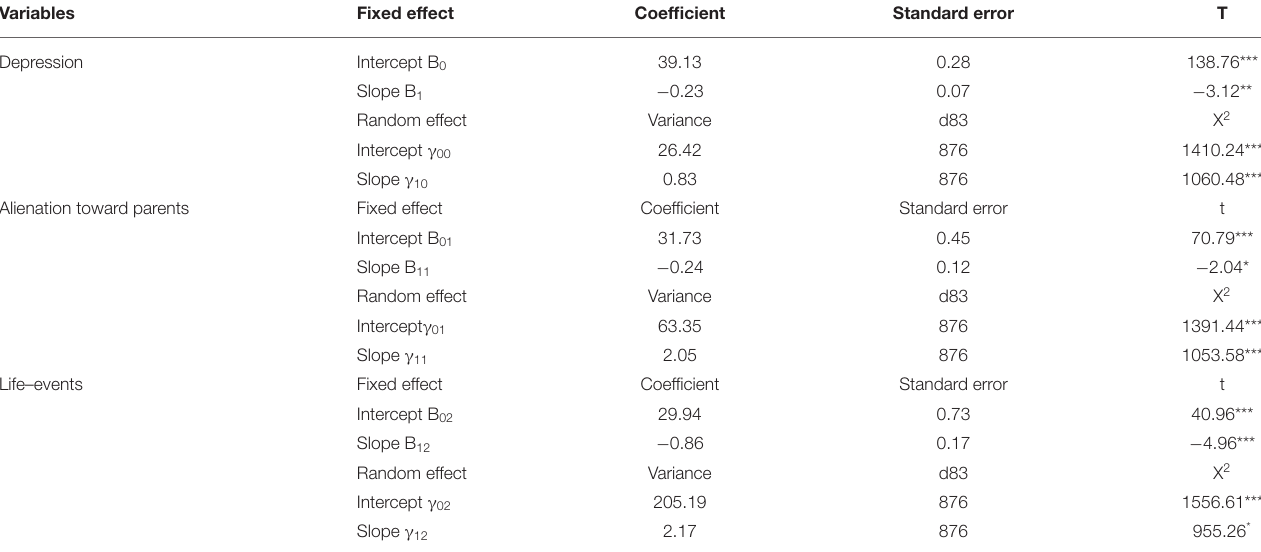
TABLE 3 | Estimated results of the unconditional model.